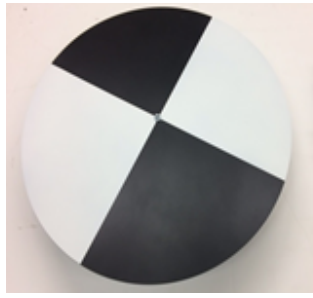
Fig. 2. Ground target image.